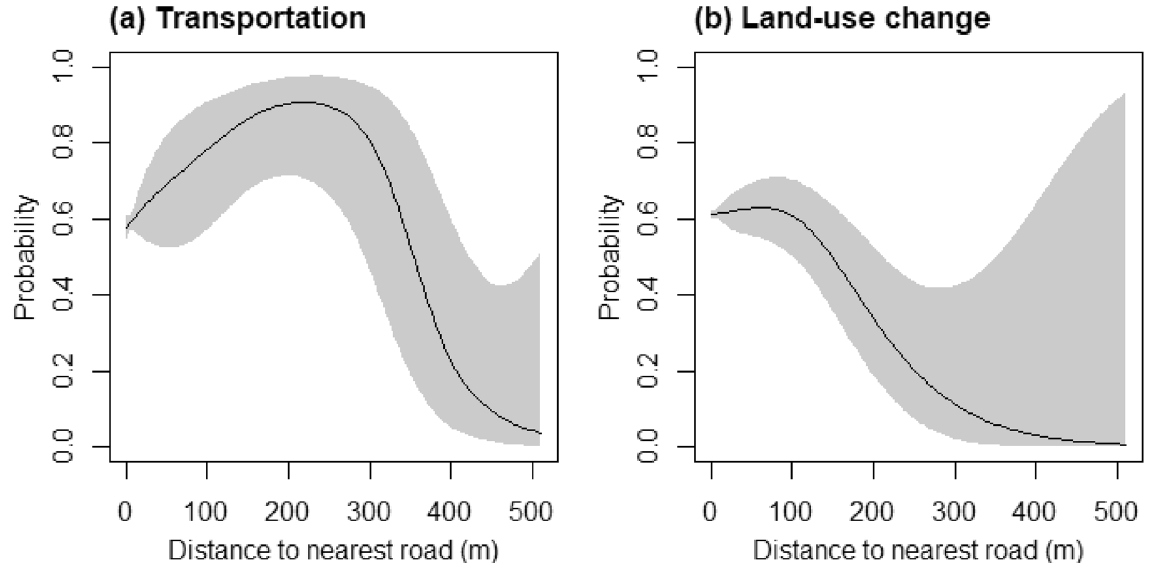
Figure 7. The non-linear associations between the distance to nearest road and ( a ) transportation ( b ) land-use change from 2014 to 2017. The x-axis is the distance of a sampling tube to the nearest road; the y-axis is the probability of RIFA successful invasion or remaining at the highest level of